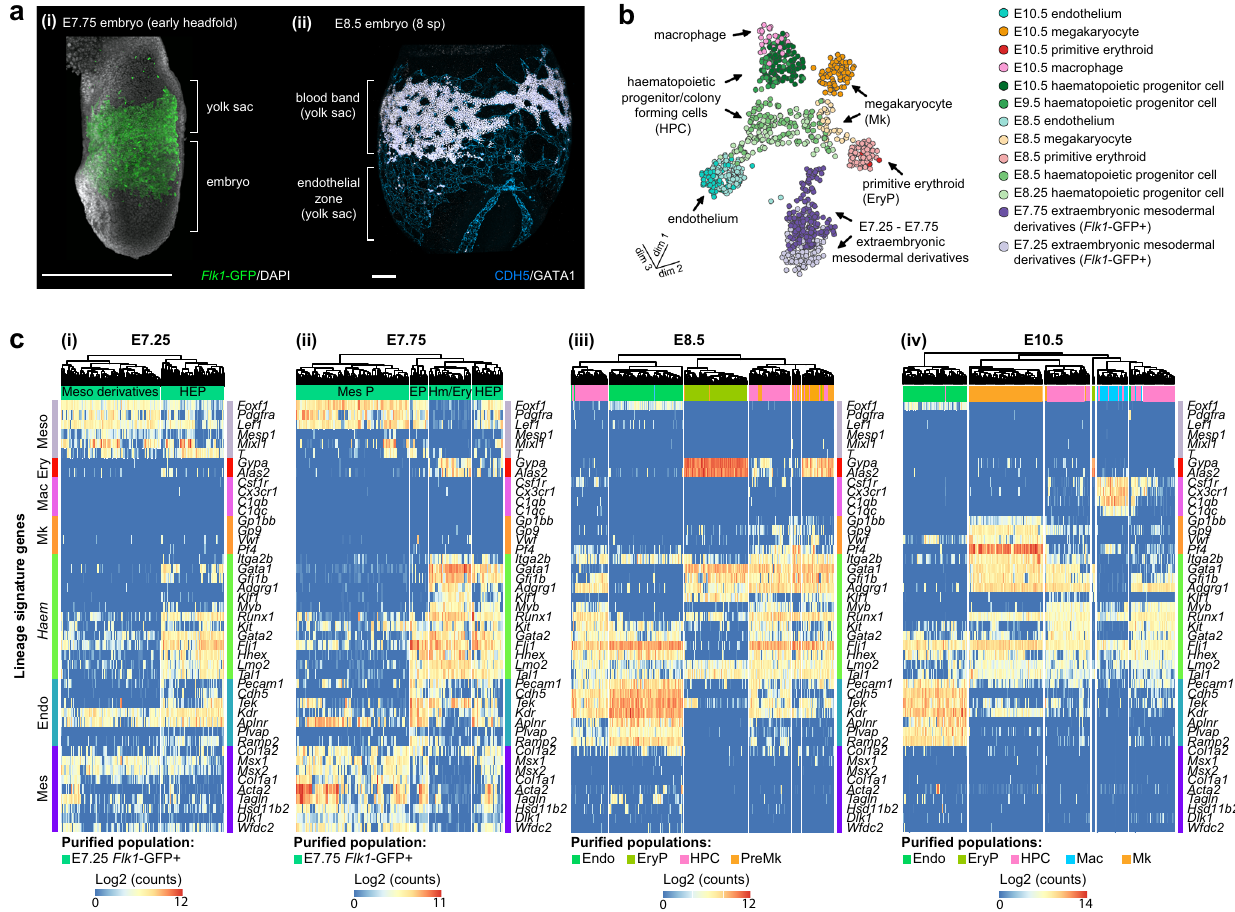
Fig. 1 | Single-cell transcriptomics pro fi ling of the early endothelial- haematopoietic landscape. a (i) Distribution of Flk1 -GFP-expressing extra- embryonic mesodermal derivatives at E7.75 ( n =7 embryos); (ii) Distribution of haematopoietic cells (GATA1+, white) and endothelium (GATA1 − CDH5+, blue) at E8.5 ( n =12 embryos). Scale bars, 300 μ m. b UMAP dimension reduction repre- sentation of 926 transcriptomes from cells collected from the yolk sac between E7.25 – E10.5. c (i) Heatmap of key mesodermal, haematopoietic, endothelial,